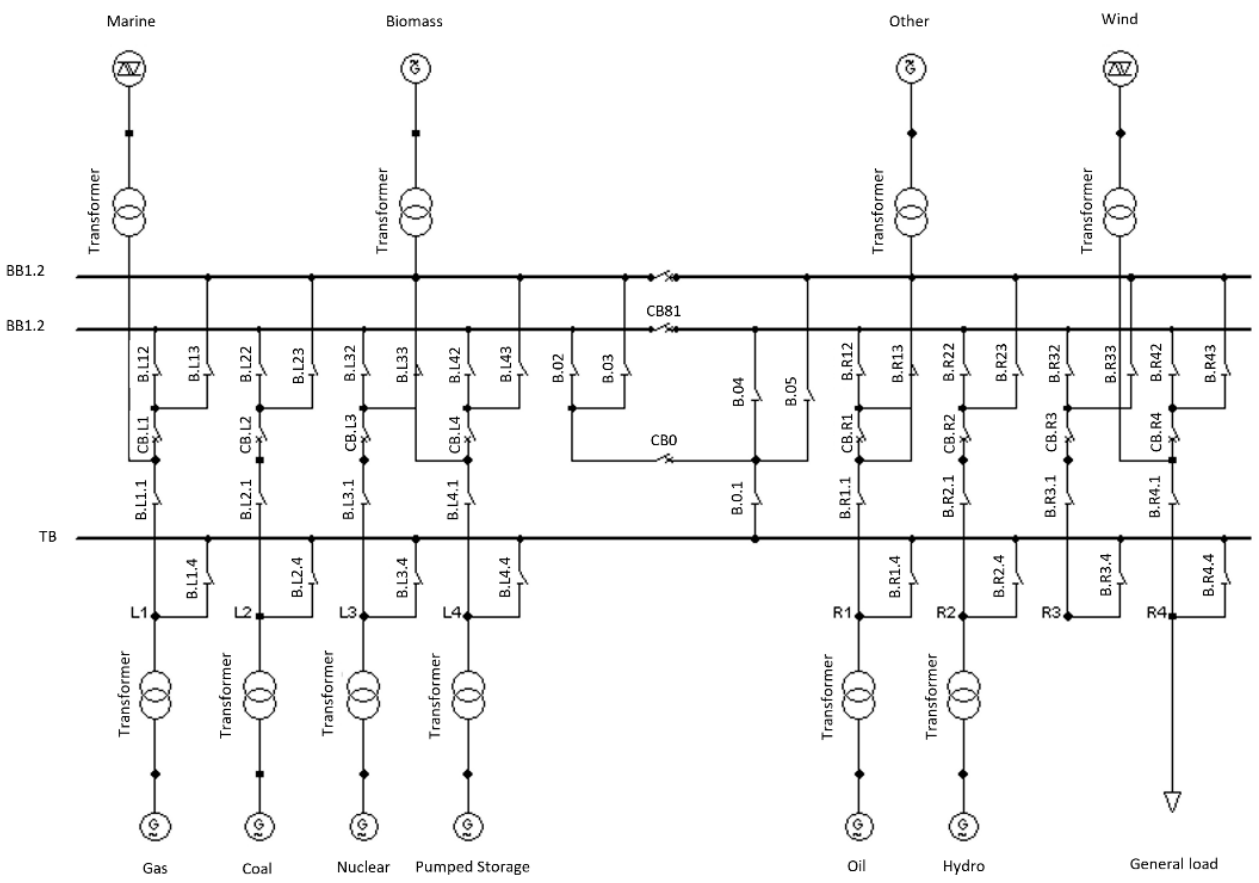
Figure 4. Substation layout in the Reduced Model (2012), representing a single zone [23].